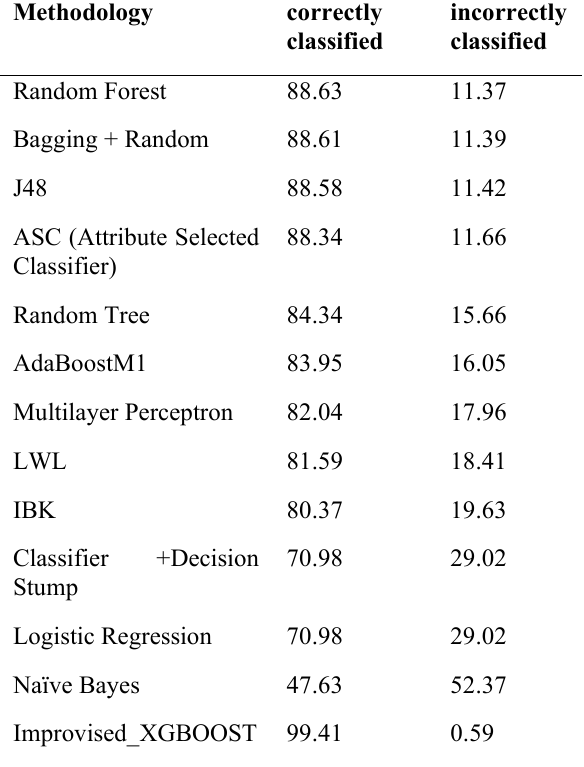
Table 3. Comparison of various methodology on the correct and incorrect